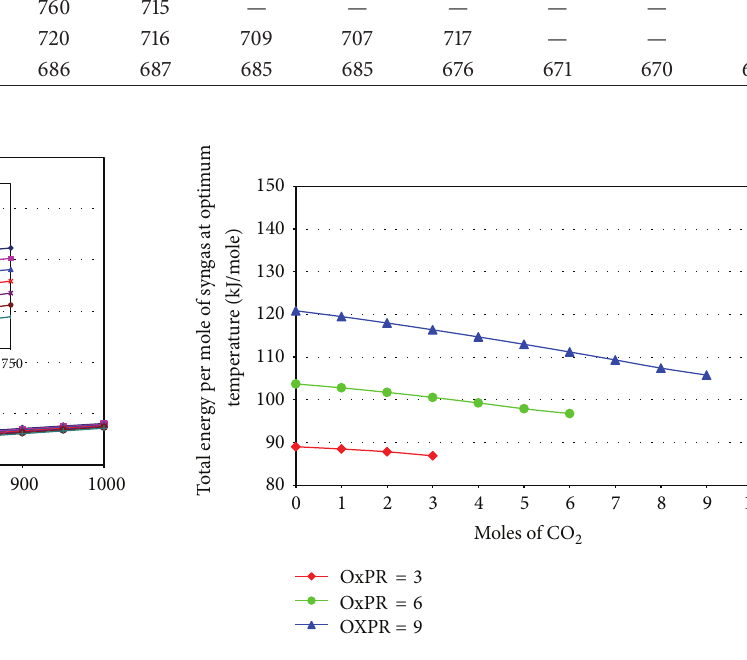
Figure 6: Minimum total energy per mole syngas at optimum temperature in CR of propane.